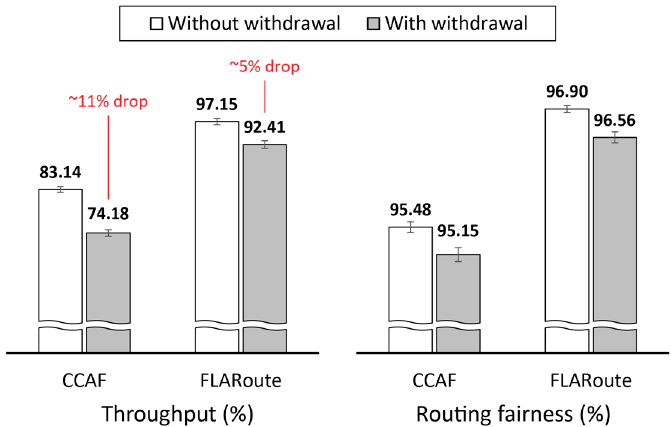
Figure 26. Throughput and routing fairness with and without users withdrawing participation from the network.